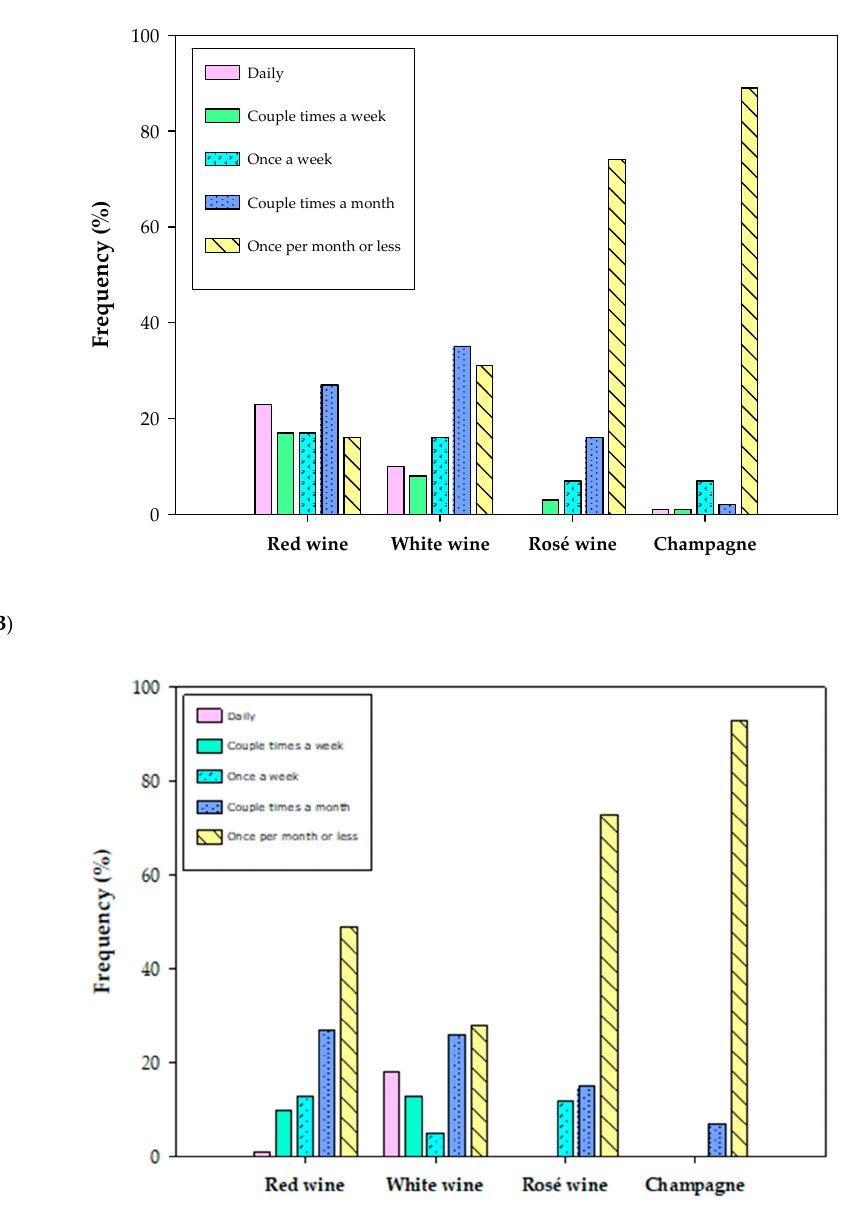
Figure 2. Consumer habits regarding wine consumption in Spain ( A ) and Poland ( B ).